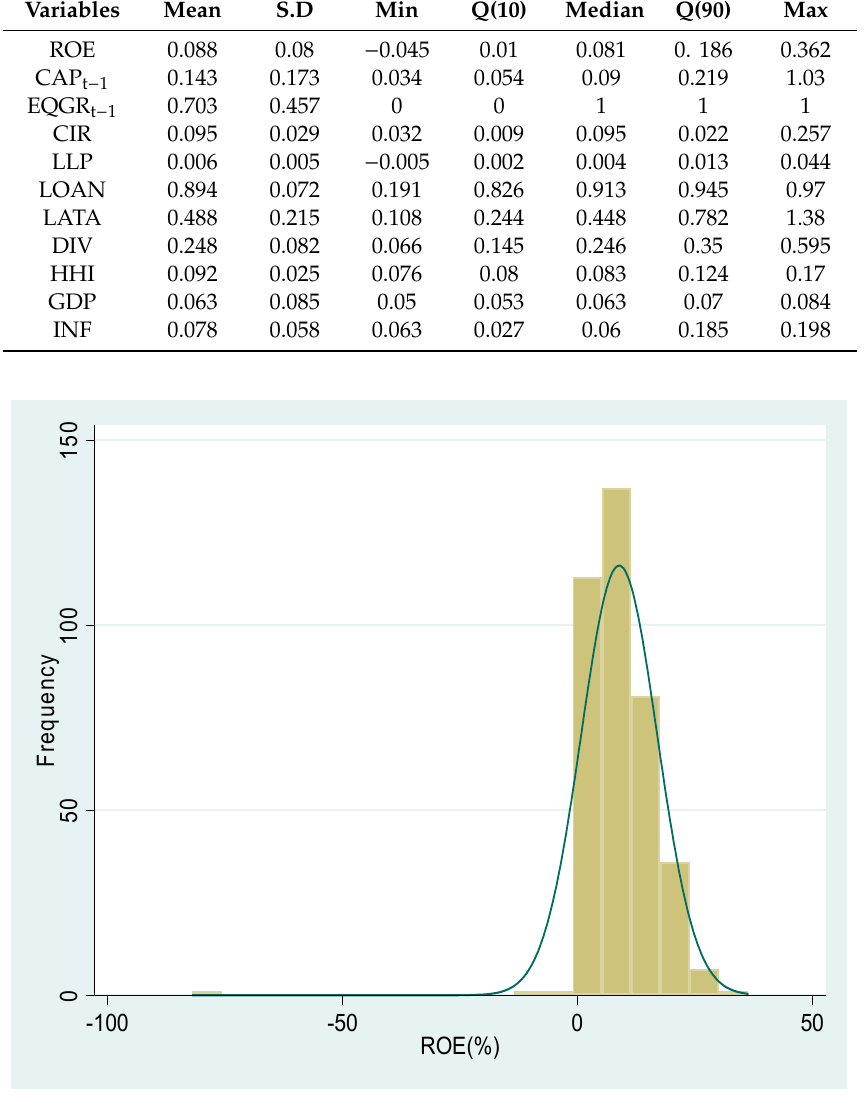
Figure 1. Histogram for 𝑅𝑂𝐸 . This figure presents the histogram and normal density for 𝑅𝑂𝐸. Table 3. Correlation matrix of variables used .